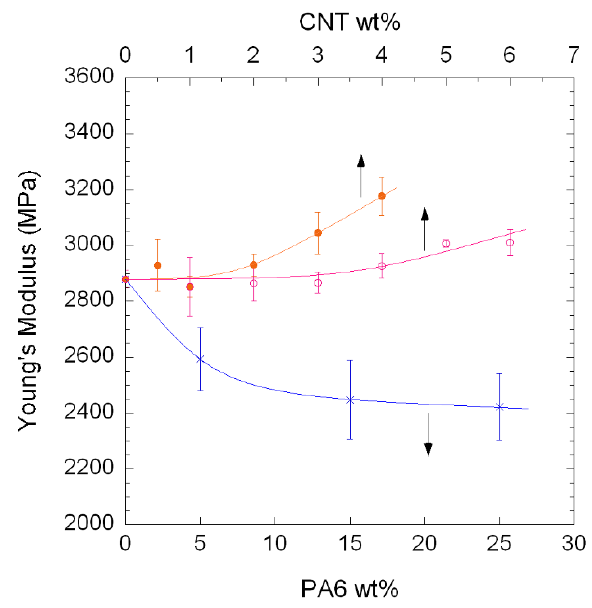
Figure 6. Glass transition temperature ( T g ) of the unfilled PA410/PA6 blends ( ○ ) and PA410/PA6/CNT NCs (●) vs. CNT and PA6 content. ), PA410/PA6/CNT NCs ( (cid:35)